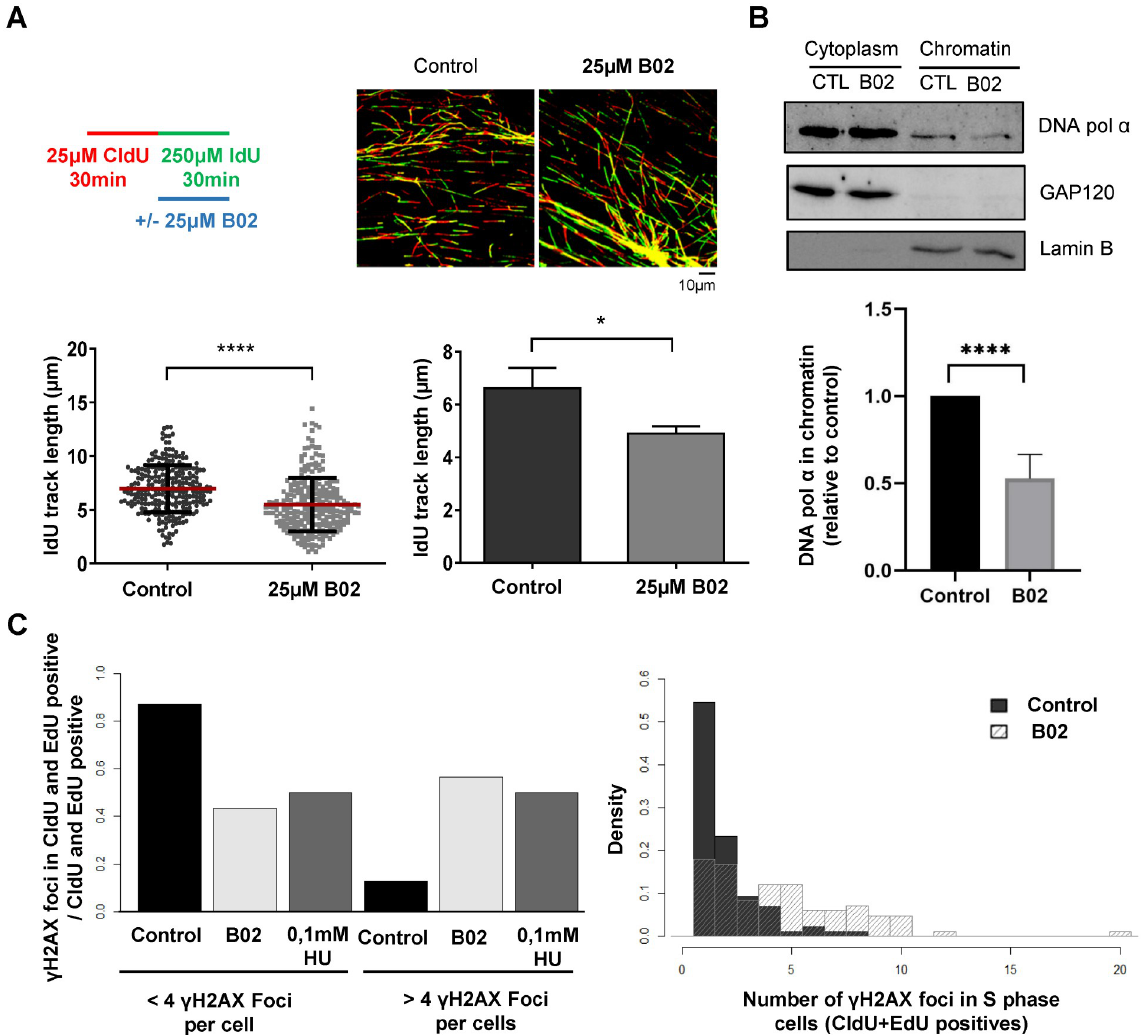
Fig 6. RAD51 inhibition affects fork progression during unperturbed conditions in HCT116 cells. (A) Cells were labelled as indicated (upper-left panel), adding the B02 inhibitor with the second analogue. After labelling, cells were harvested and prepared for DNA fiber analysis. Representative images are shown (upper-right panels). The IdU track length was measured. At least 250 fibers of each condition in each experiment were measured. One representative experiment out of three is shown (bottom-left panel, Mann-Whitney test, ���� P value < 0.0001). Means and standard deviation (bars) of three experiments are shown (bottom-right panel, paired t-test, � P value < 0.05). (B) cells were treated (B02) or not (CTL) with B02 for 4h and then cytoplasm and chromatin fraction purified as indicated in the methods section. DNA polymerase α (DNA pol α ), and Lamin B and GAP120 (as controls of cell fractionation and proteins loading in the gel) were analyzed by western blot. A representative WB (upper panel) and quantification of 5 biological replicates (lower panel; mean and standard deviation, t- student test, ���� P value < 0.001) are shown. (C) Cells were pulse labeled with CldU, treated with B02, HU, or no-drug (control) and pulse- labeled again with EdU. After processing for Immunofluorescence to detect CldU, EdU and γ H2AX, images were acquired and analyzed as indicated in the methods section. A representative experiment is shown. B02 versus Control γ H2AX foci number distribution is significantly different according to Mann-Whitney test, ���� P value < 0.0001. See data used for quantification in S1